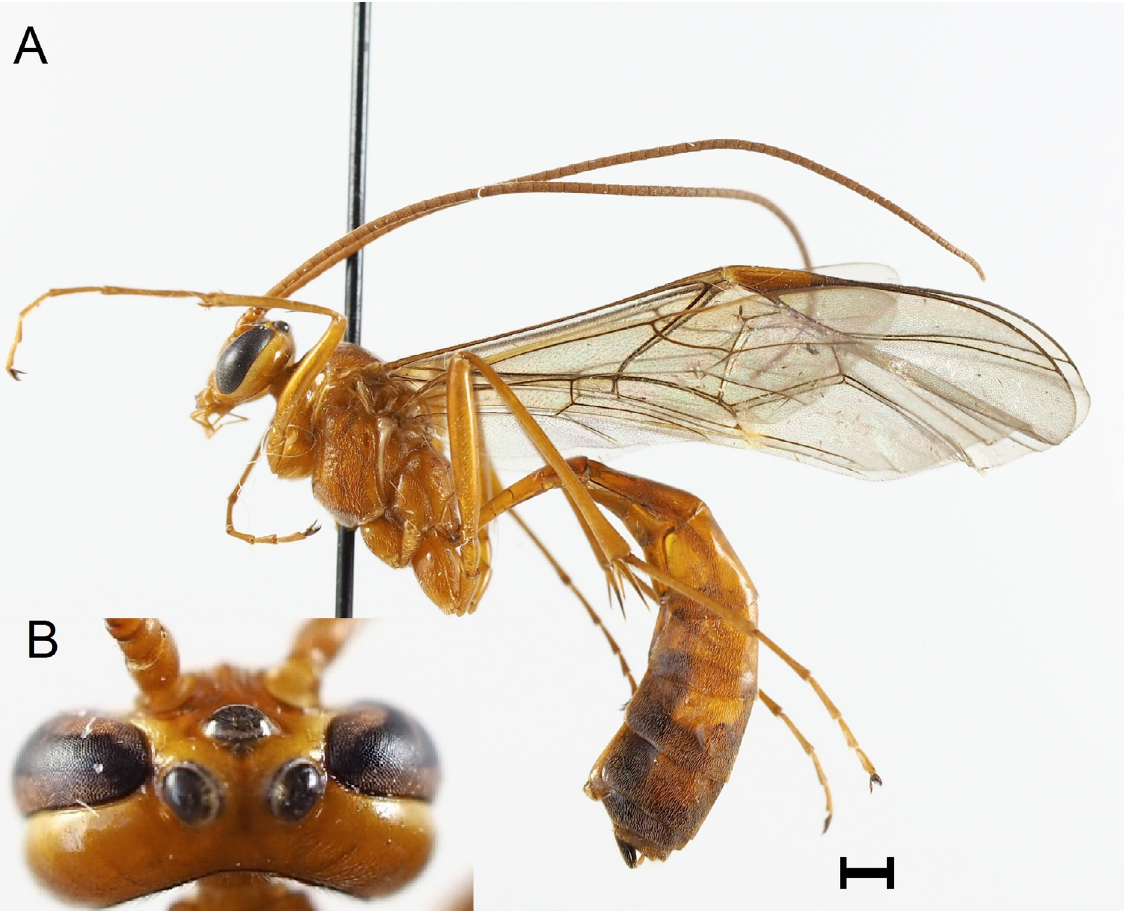
Fig. 30. Ophion crassicornis Brock, 1982, ♀. A . habitus lateral view. B . head dorsal view. Scale bar: A = 1